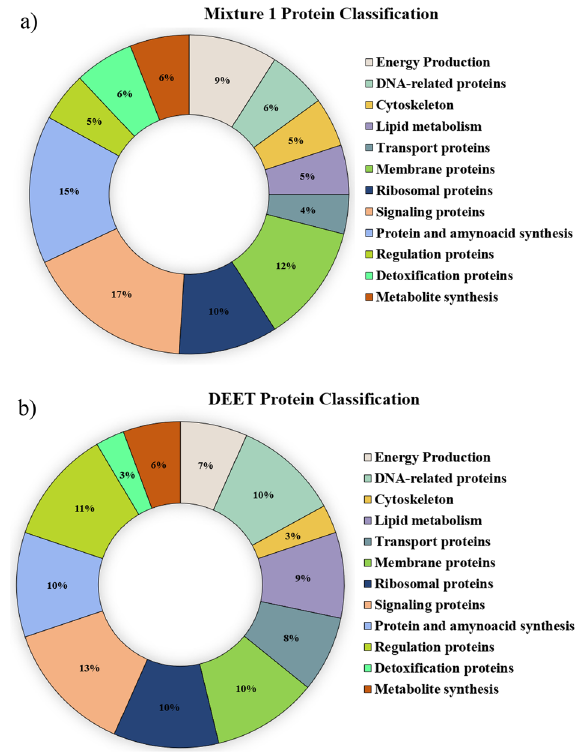
Figure 6. Protein classification according to the cell function. ( a ) Protein classification regarding the mixture 1 (geranyl acetate, α-bisabolol, and nerolidol) at 100 mg/mL. ( b ) Protein classification for the DEET treatment at 100